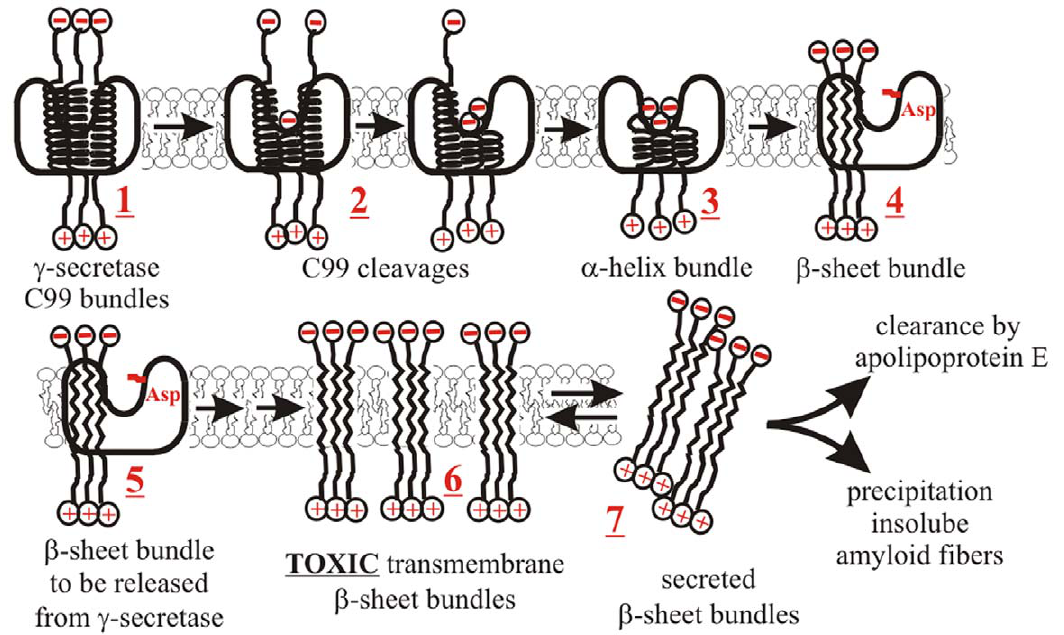
Figure 11. Multiple C99 molecules bound to c -secretase can facilitate the pathogenesis. Multiple C99 molecules bound to c -secretase can affect the catalytic mechanism and contribute to the neurotoxic events. Multiple C99 molecules bound to the enzyme (1) could interact just as free C99 molecules [42–46]. Such interactions can influence the initial AICD cleavage and thus control the difference between A b 49–46–43–40 or A b 48–45–42 cleavage paths (Fig. 10). If multiple C99 molecules are cleaved in parallel, the result will be a bundle of nascent A b peptides (3), or even a mixed bundle of C99andnascentA b peptides(2). Allof thoseinteractions canbeaffectedbythesame structuralforces thatcontrolinteractions betweenA b peptides infree solution. Thus, there could be a preferred number of peptides in the bundle [52,53], and a preferred ratio between A b 40, A b 42, and the longer A b peptides [56]. Any of those can affect dynamic structural changes that control the processive cleavages, and ultimately the type of A b products (Fig. 10). Packed together the nascent A b peptides can undergo a series of structural changes so that their b -genic amino acids (Thr, Val, Ile) can initiate formation of extended b -sheet bundles (3- . 4) [51–54,57,58]. This can drive transition from the a -helix structure of C99 to the b -sheet structure of A b oligomers [51– 54,57,58].The whole process can be chaperoned andaccelerated by the enclosurewithin theenzyme structure. Some functional and evolutional links have been observed between chaperones and rhomboid intramembrane proteases [95,96]. Unlike single amyloid peptides (Fig. 10), the hydrophobic b -sheet bundles can be easily released into the lipid bilayer (5– . 6). The bundles can be stabilized by hydrogen bonding between the peptides’ backbones so that their hydrophobic amino acids can face the lipid bilayer [51]. The released b -sheet bundles can accumulate to toxic levels by causing disruption of membrane integrity(i.e. fluidity,lipid rafts andion gradients[51,97]).Thus, the neurotoxic processes can start directly in themembrane where toxic amyloid peptides are produced, rather than in the extracellular space as it was suggested in the original amyloid hypothesis and its subsequent derivatives [51]. Extracellular amyloid fibrils can be the end result of chronic toxic overload and the final membrane breakdown ( 7 )